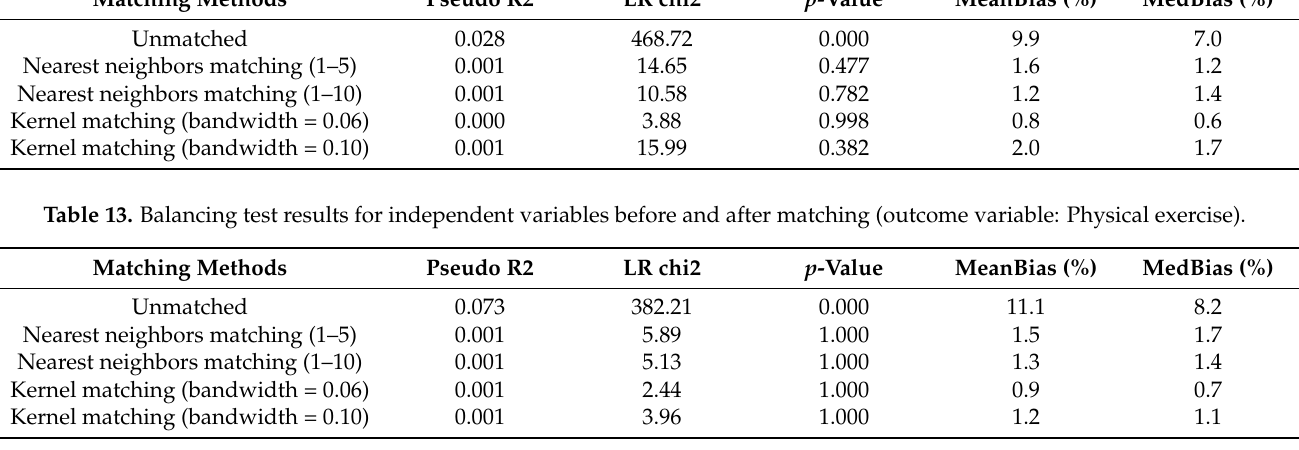
Table 12. Balancing test results for independent variables before and after matching (outcome variable: Nutrition balance). Matching Methods